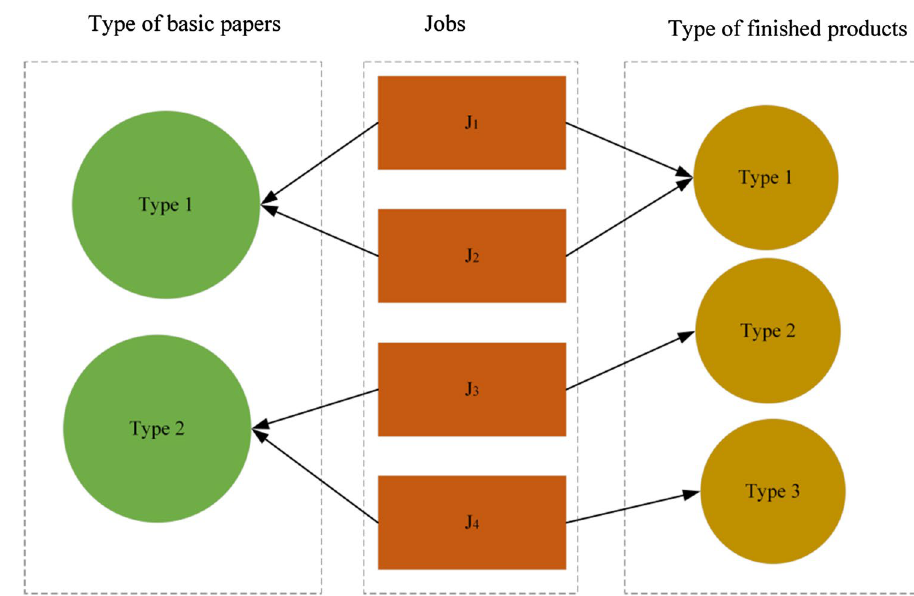
Fig. 1 The example of types